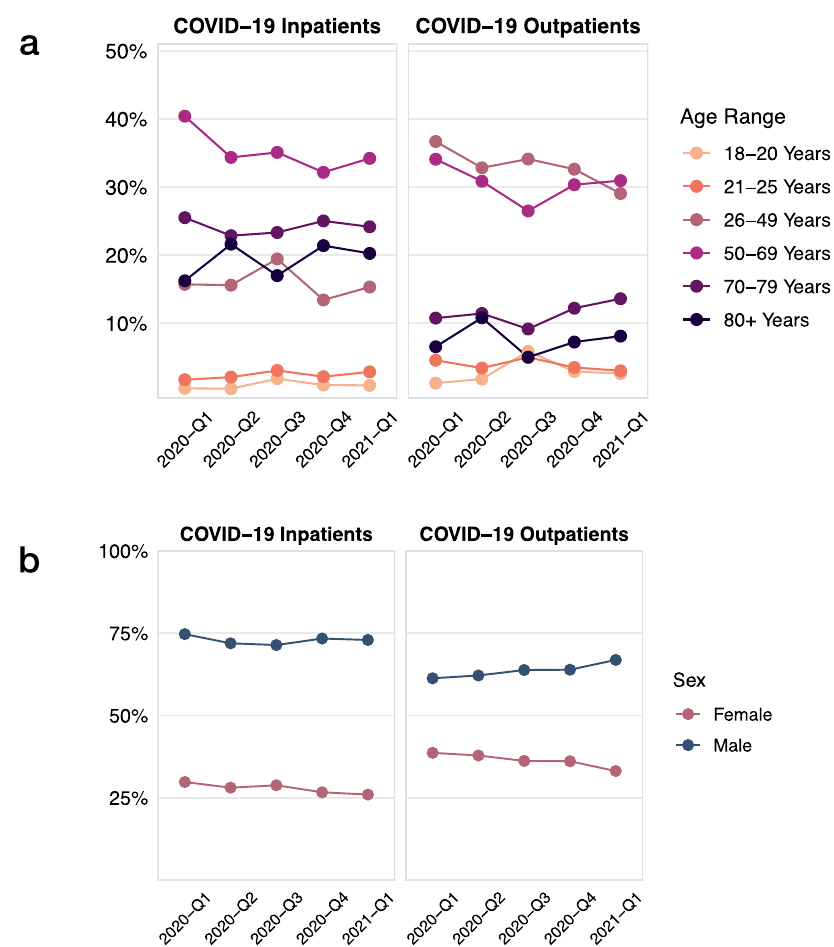
Fig. 1 Demographic trends for age and sex across calendar time in the study population. a Age trends among inpatient COVID-19 cases and outpatient COVID-19 cases. b Sex trends among inpatient COVID-19 cases and outpatient COVID-19 cases.